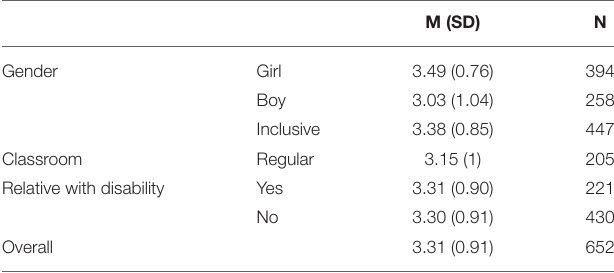
TABLE 1 | Descriptive statistics by independent